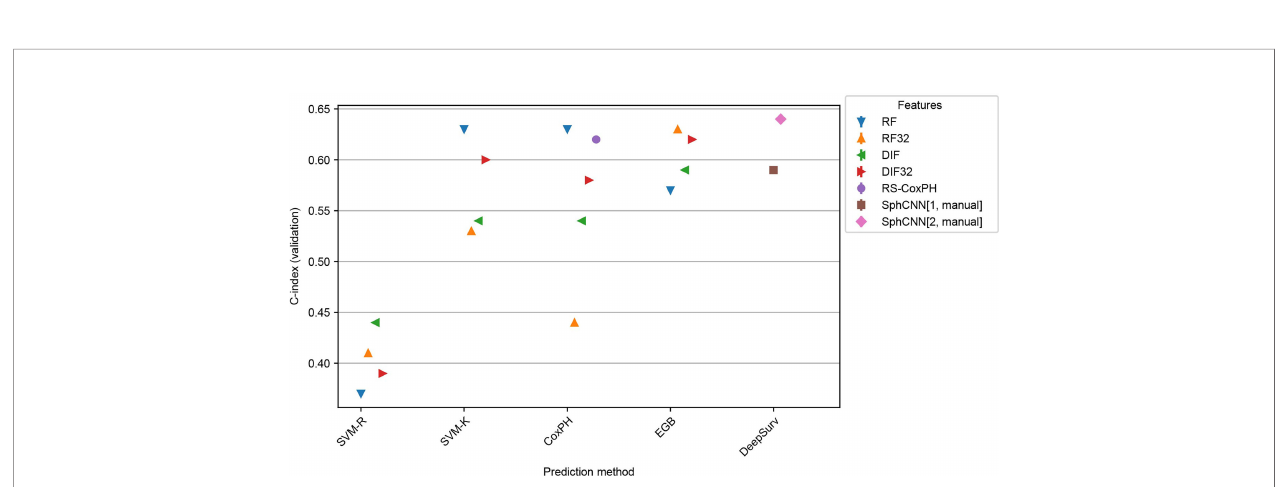
FIGURE 8 | Performance comparison for the models trained on Lung1 and evaluated on H&N1. We used the prediction methods and features as labelled in Figure 6 with the exception that no automatic segmentation was evaluated